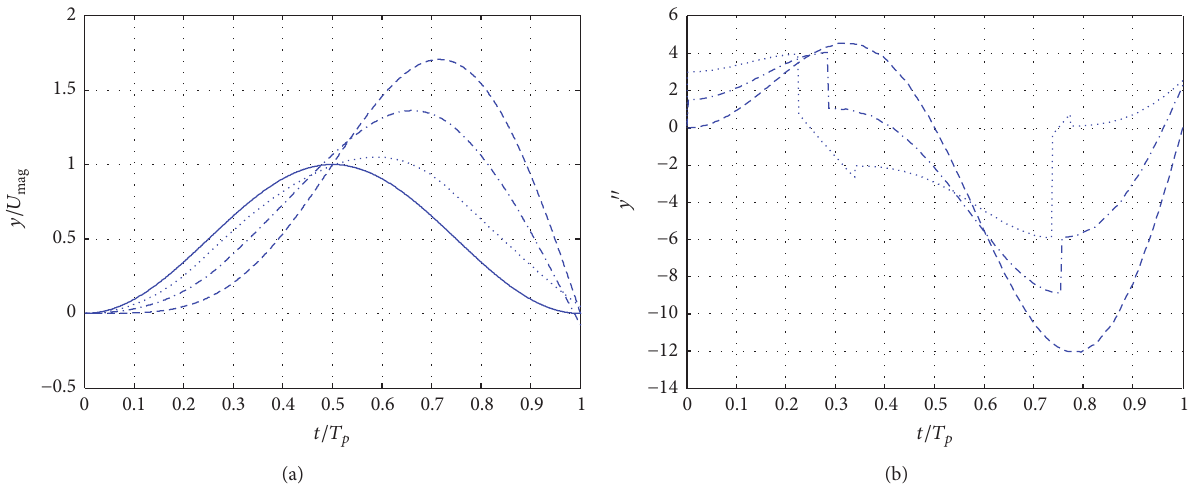
Figure 2: Response of a single-degree-of-freedom system with friction under versed sine base input. (a) Displacement response. (b) Acceleration response. Nondimensional base input magnitude 𝑈 ̂𝐹 = 0 corresponds to , that is, no friction. The dash-dotted line corresponds to